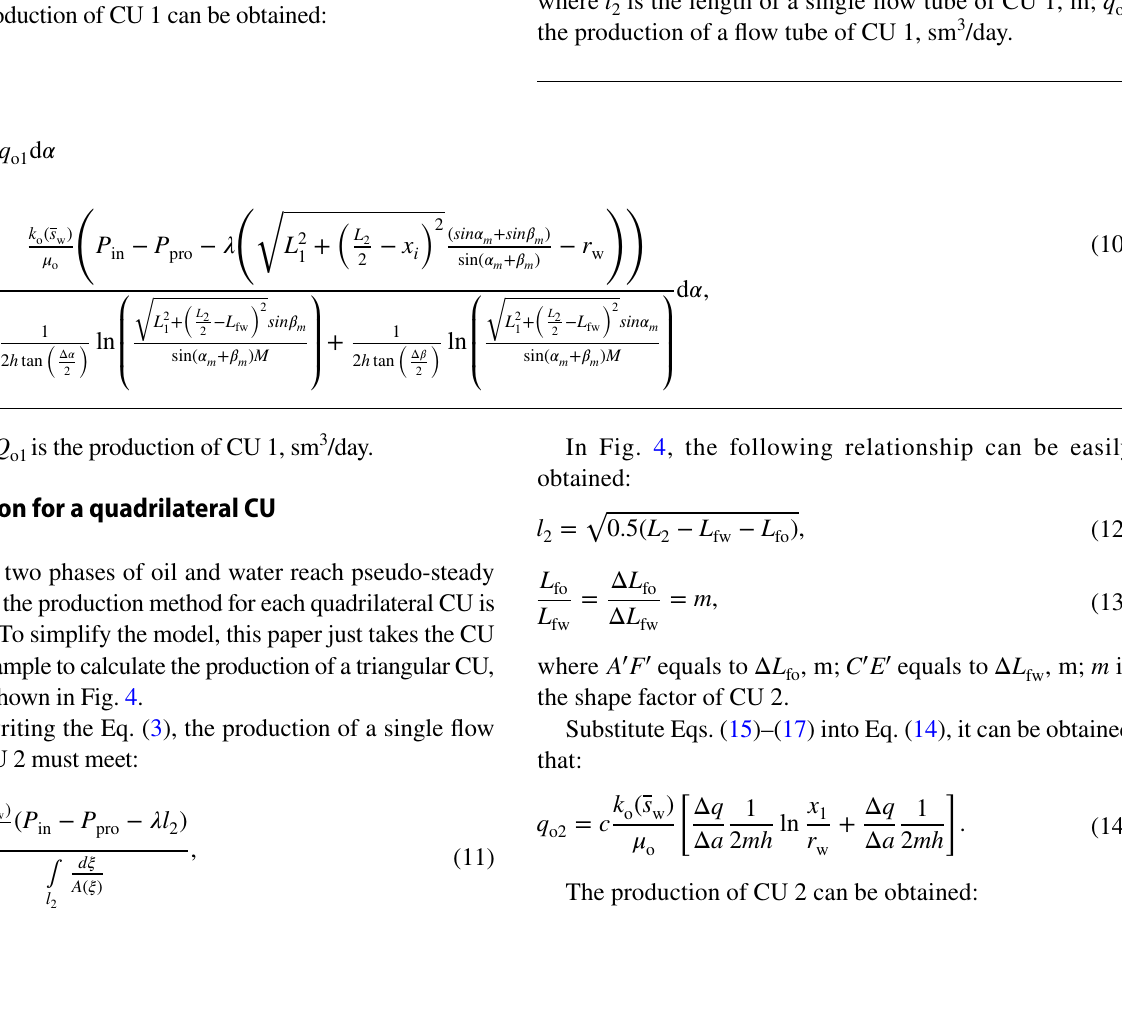
Fig. 4 The illustration of CU 2 and its flow tube in the situation L L where wf ≠